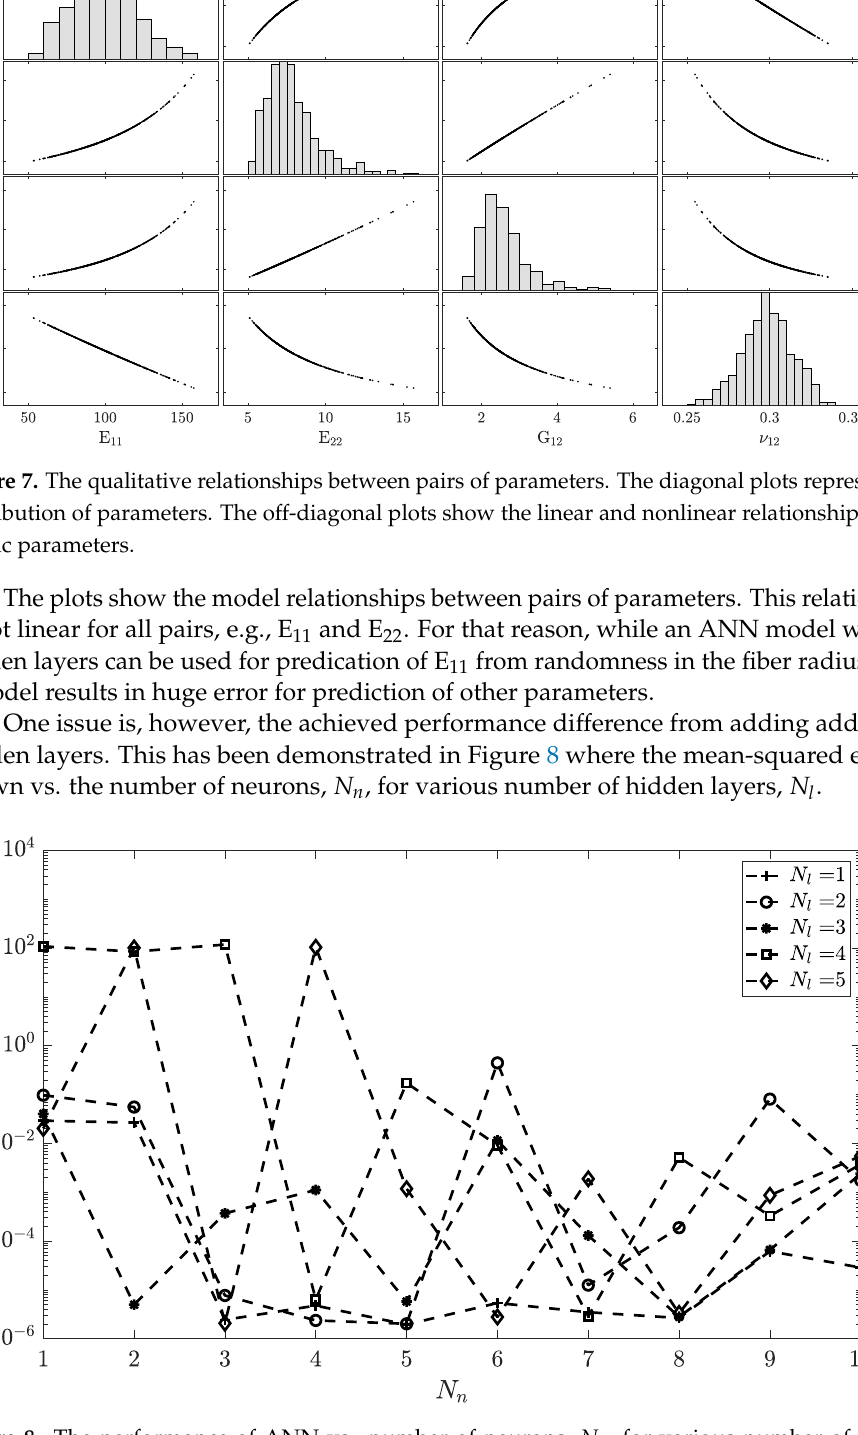
Figure 8. The performance of ANN vs. number of neurons, N n , for various number of hidden layers, N l